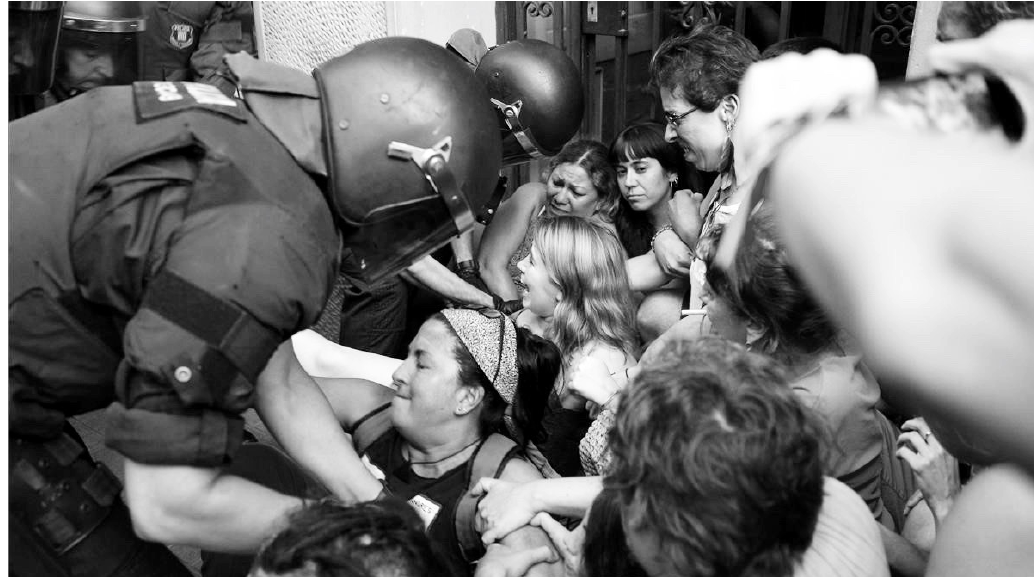
Figure 7. Eviction of several families in the building of 151 Entença Street purchased by an investor. Source: Castán (2017). Urban Planning, 2018, Volume 3, Issue 3, Pages